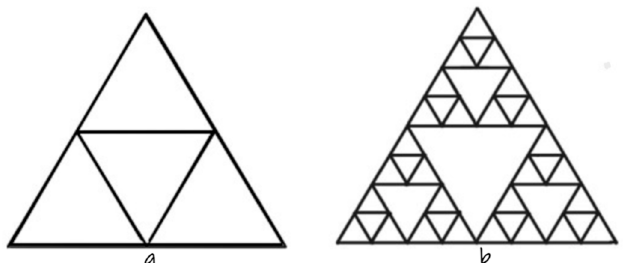
Figure 1. ( a ) Hegel’s “Triangle of Triangles” (adapted from [1] (p. 149)). ( b ) A Sierpinski Triangle, with three levels of iteration.